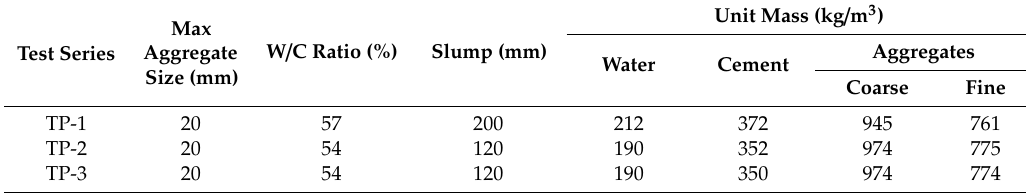
Table 1. Concrete mix proportions for the three sets of